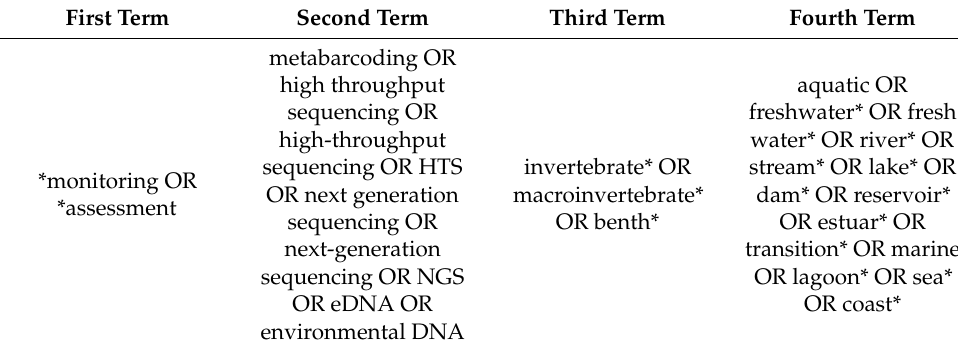
Table 1. Combinations of terms used to search the Web of Science for articles involving bioassessment, DNA metabarcoding, benthic macroinvertebrate taxa, and aquatic ecosystems. The presence of the * in some search terms means that any words containing them after or before should be displayed in the search (e.g., *monitoring, should also display biomonitoring).